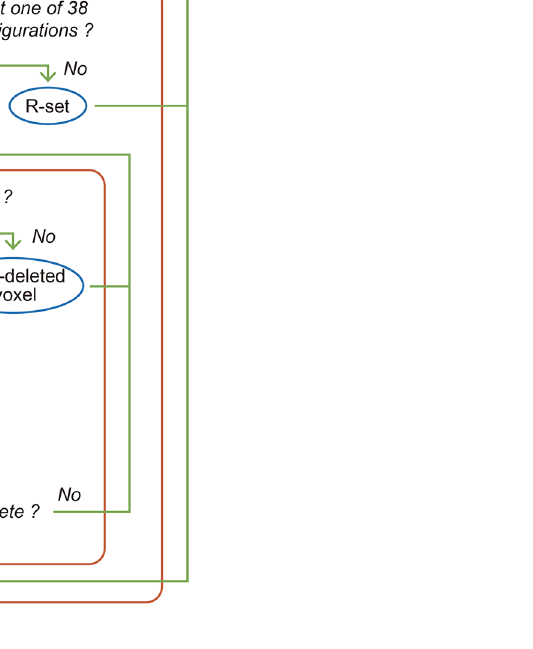
Figure 3. The iterative thinning in step